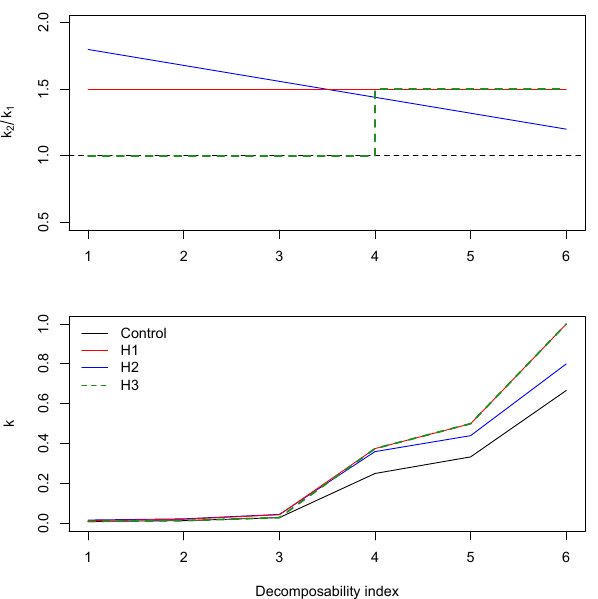
Fig. 7. Hypotheses about changes in decomposition rates due to warming and nitrogen additions. The upper panel shows the three hypotheses represented as a proportional increase in decomposition rates ( k 2 / k 1 , where k 1 is the initial rate and k 2 is the rate after warm- ing or N addition). The lower panel represents these hypotheses in absolute